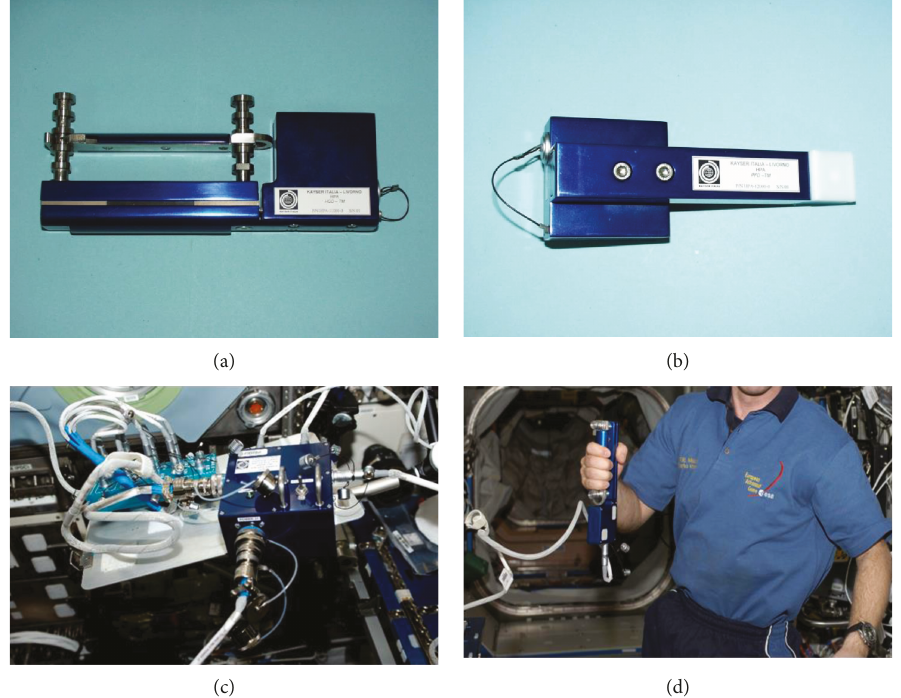
Figure 1: CHIRO instrumentation. (a) Handgrip dynamometer (HGD) tool. (b) Pinch force dynamometer (PFD) tool. (c) Interface box (IBOX) onboard ISS. (d) HPA used by an astronaut onboard ISS during the